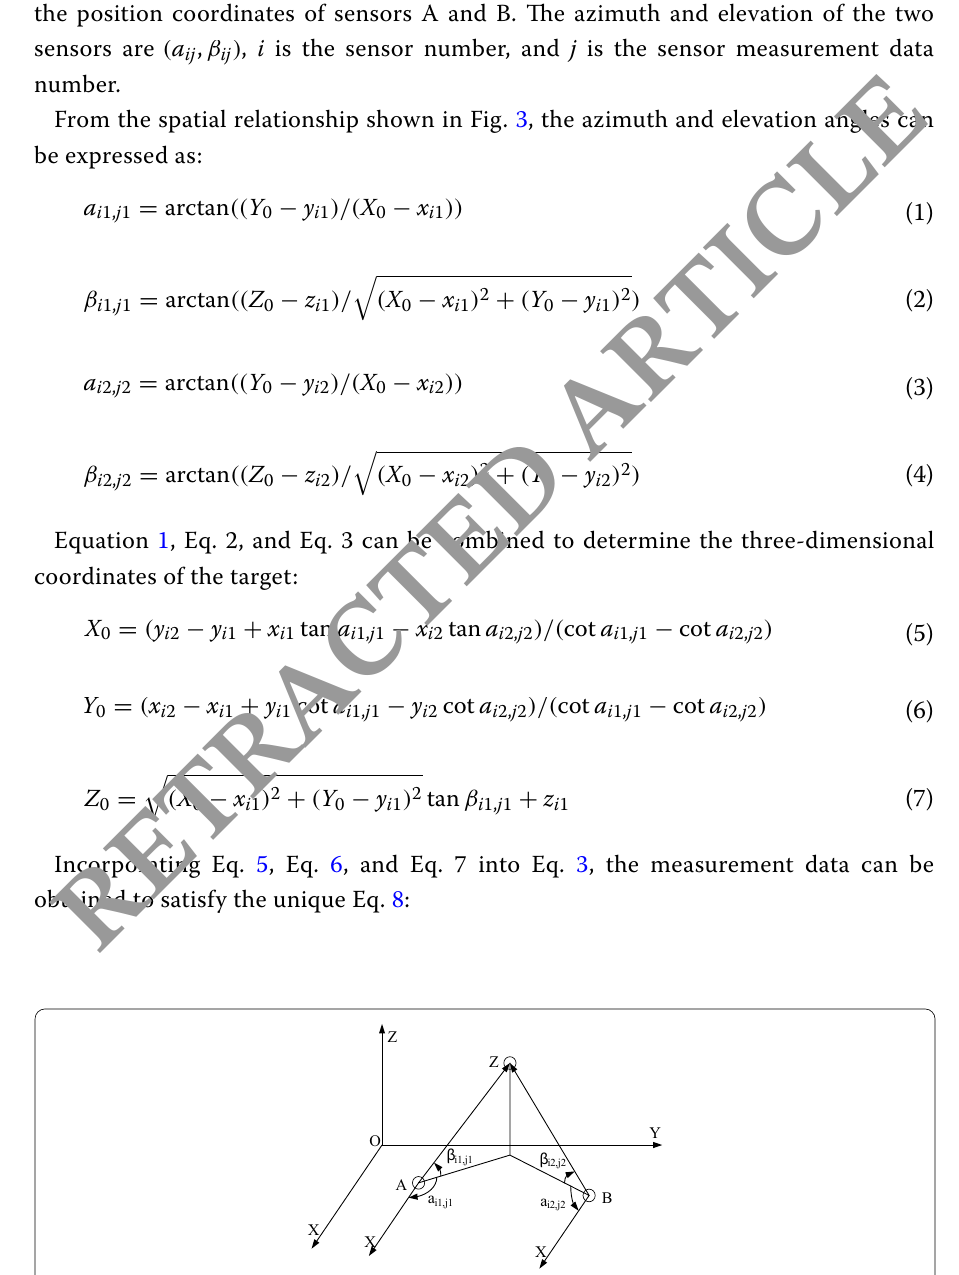
Fig. 3 Sensor detection